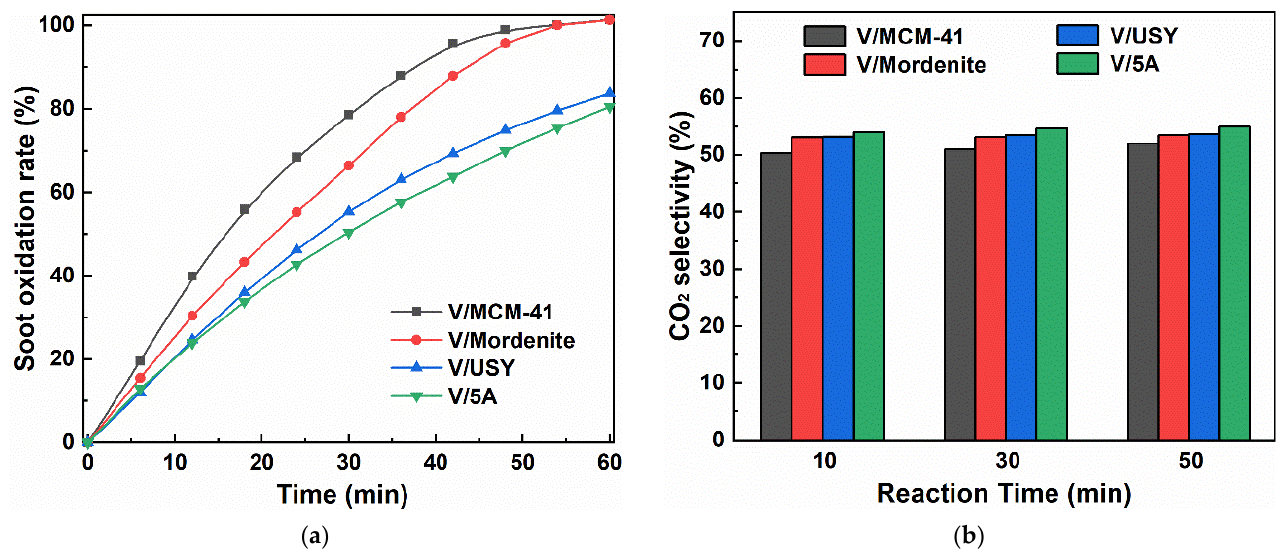
Figure 4. Plasma-catalytic oxidation of soot over V/M (M = MCM-41, mordenite, USY and 5A) catalysts at the discharge power: ( a ) oxidation rate and ( b ) CO 2 selectivity (Discharge power: 20 W, gas flow rate: 500 mL · min − 1 and reaction temperature: 25 ◦